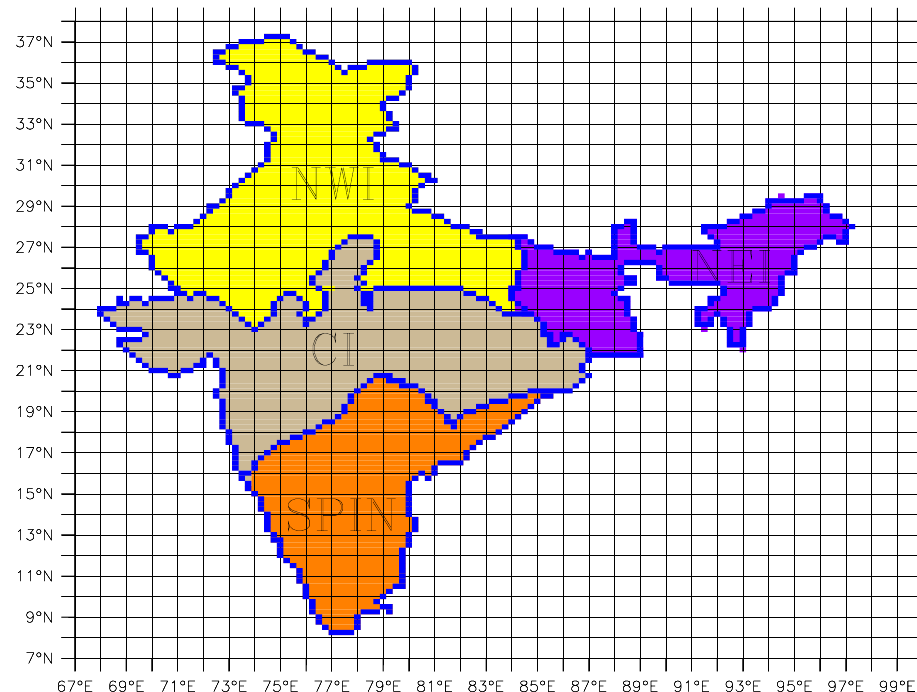
Figure 1. Map of the four Indian homogeneous rainfall zones projected on 0.25° × 0.25° daily rainfall grids used in this study. NWI, CI, SPIN, and NEI are shown in yellow, tan, orange, and purple, respectively. The borders between each IMD region are shown in blue.